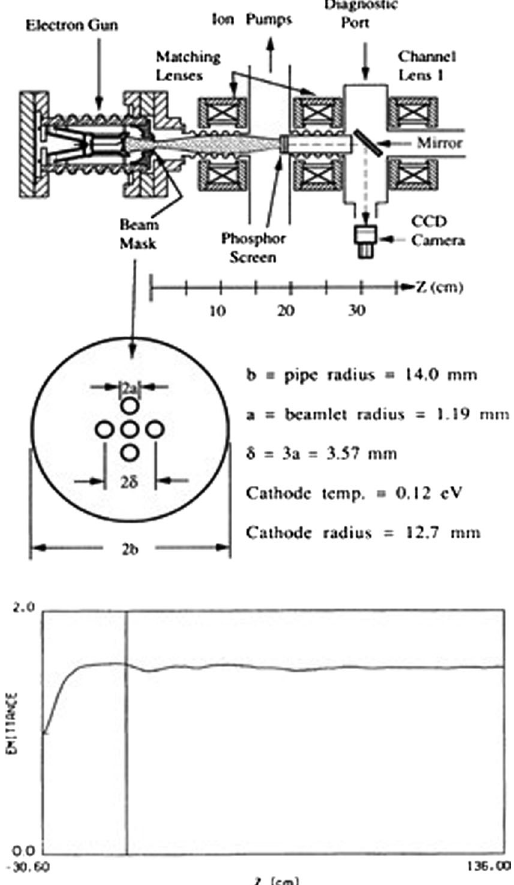
FIG. 3. Kehne ’ s PhD thesis experiment. (Top) experimental setup; (middle) description of the five beamlets; (bottom) relative emittance growth due to nonlinear free energy. (Images from [9].)